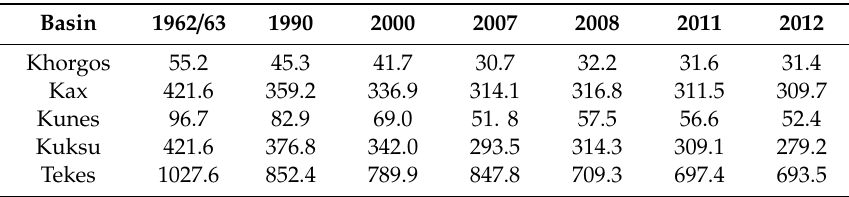
Table 8. Glacier ice area (km 2 ) in C-IRB.